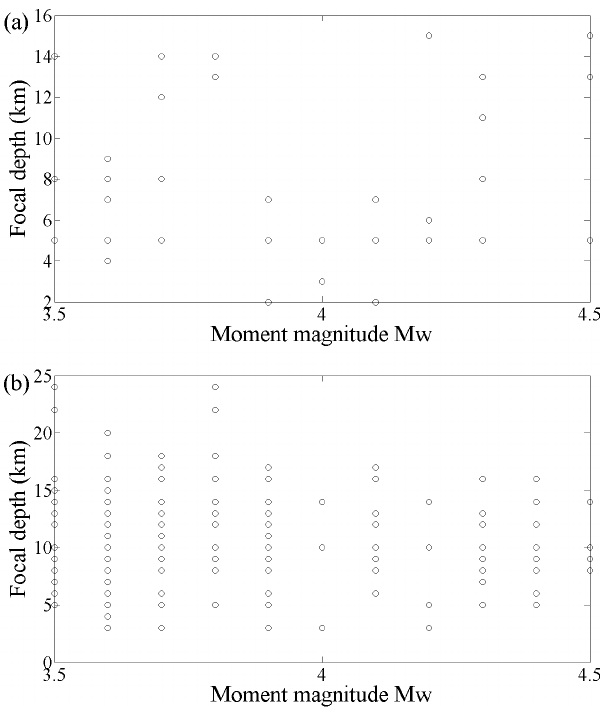
Figure 2. M w focal depth distribution of small earthquake records in (a) Sichuan region and (b) Yunnan region.